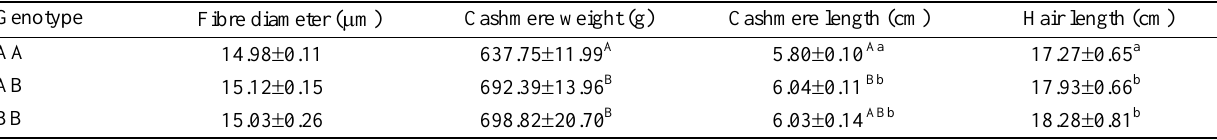
Table 2. Least squares mean values for cashmere fibre traits in Inner Mongolian cashmere goat